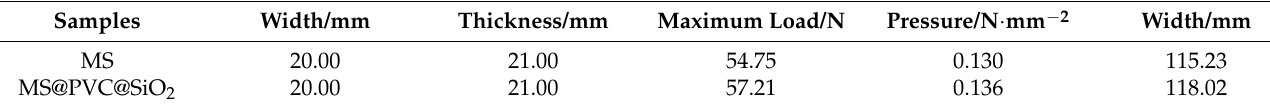
Table 1. Mechanical properties of the sponge samples.